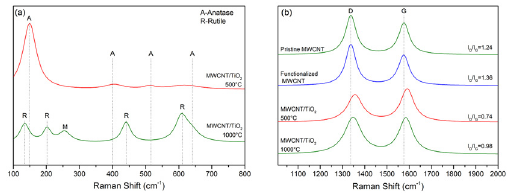
Figure 1. Raman Spectra in the range of: (a) 100-800 cm -1 from TiO coated MWCNT calcined at 500 and 1000ºC; (b) 1000-2000 cm -1 from pristine, functionalized MWCNT and TiO calcined at 500 and